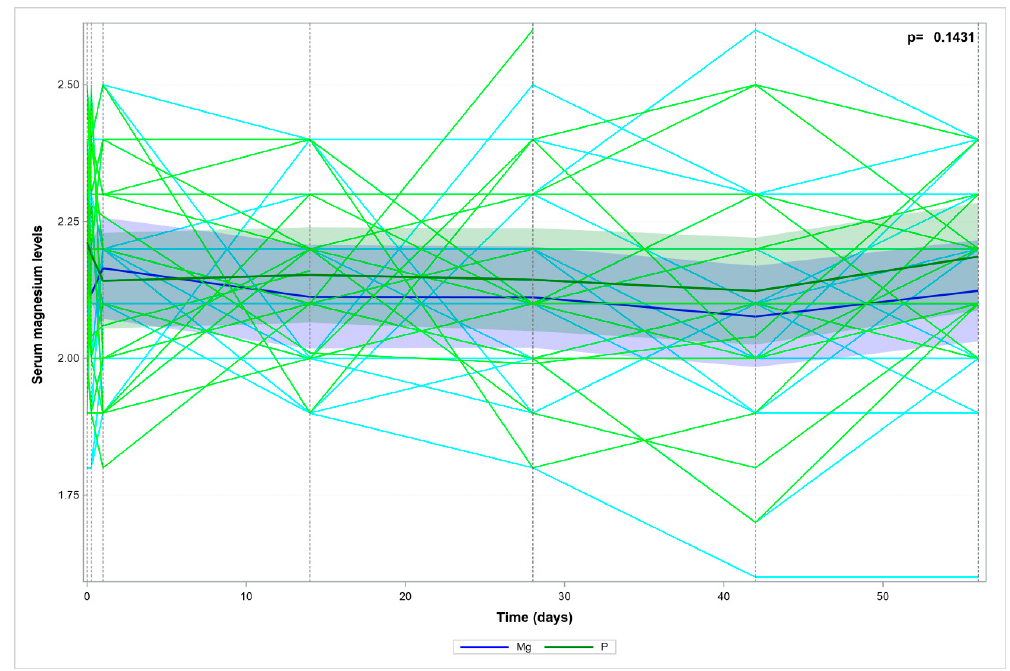
Figure 2. Serum magnesium levels over time—the measured data and trend.